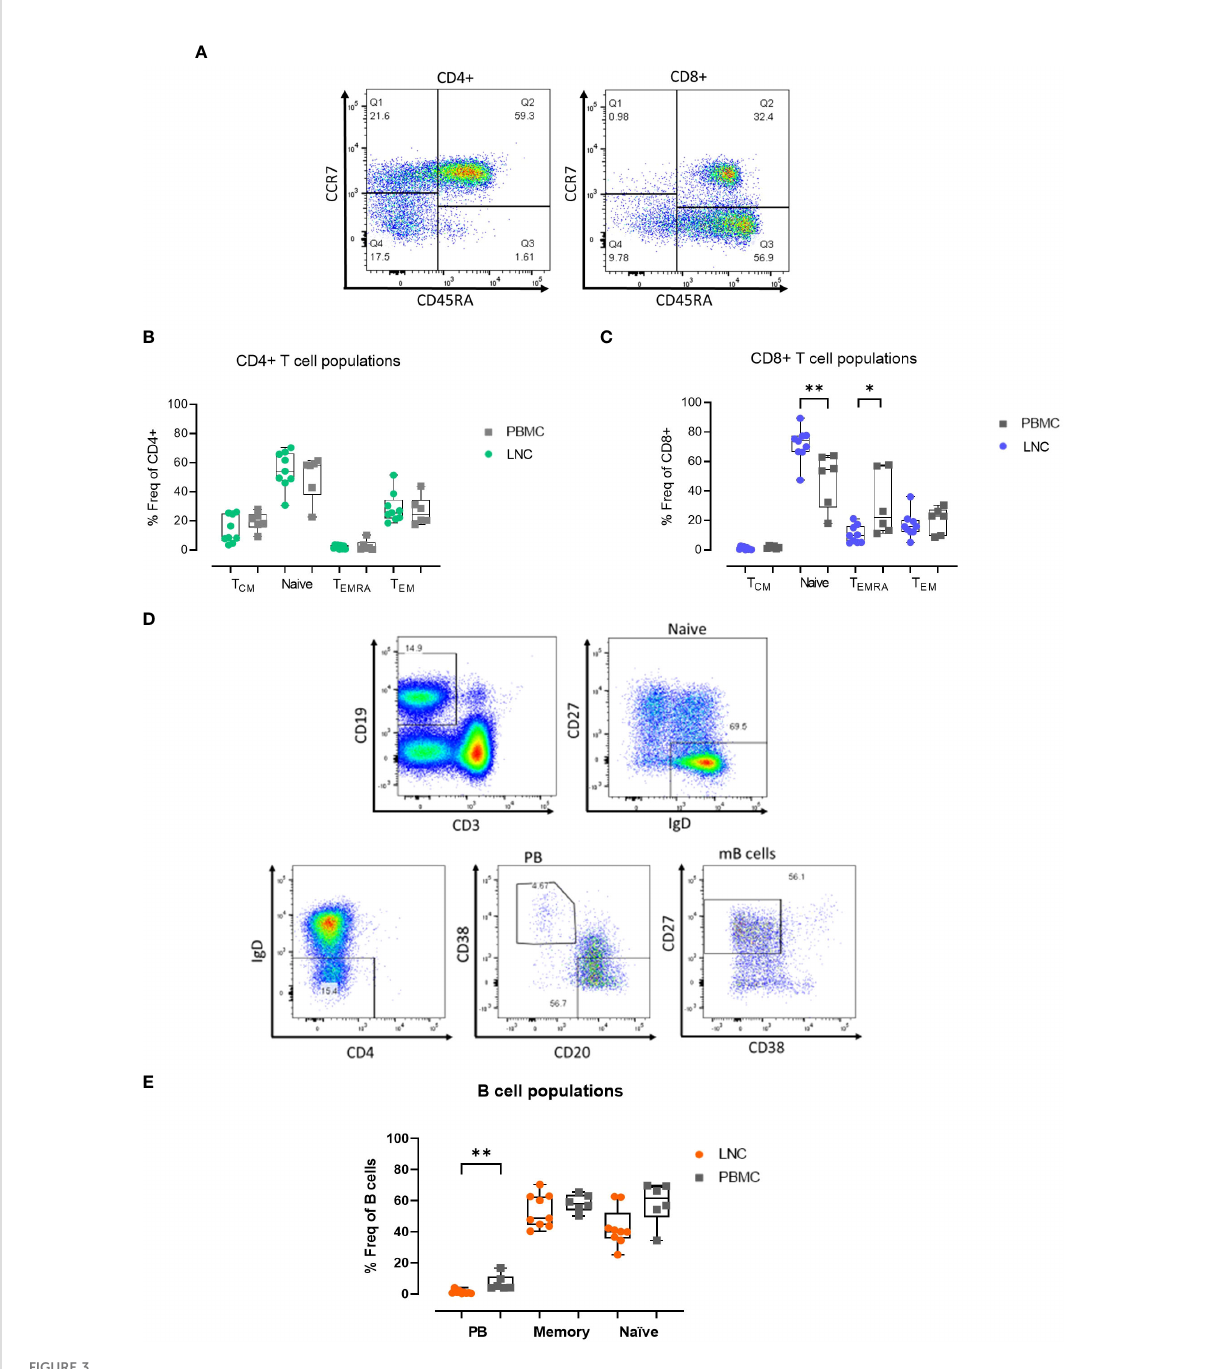
FIGURE 3 Memory T and B cell subset distribution in blood and lymph node. (A) Representative gating strategy for CD4+ and CD8+ T cell memory subset populations for surface expression of CCR7 and CD45RA on live, CD3+ CD4+/CD8+ singlets; de fi ned as Tcm, CCR7+ CD45RA- (Q1), Naïve; CCR7+ CD45RA+ (Q2) Temra; CCR7- CD45RA+ (Q3) and Tem; CCR7- CD45RA- (Q4) subsets for CD4+ T cells (left panel) and CD8+ T cells (right panel). (B) Comparison of frequencies of CD4+ T cell memory populations in PBMC and LNC. (C) Comparison of frequencies of CD8+ T cell memory populations in PBMC and LNC. (D) Representative gating strategy of memory B cell subsets with CD19+CD3- live B cells gated for naive IgD+CD27-, IgD-CD38+CD20- plasmablasts and CD27+CD38- memory B cell subsets. (E) Comparison of frequency of B cell subsets in PBMC and LNC. The results of Mann-Whitney U tests are shown with *p<0.05,